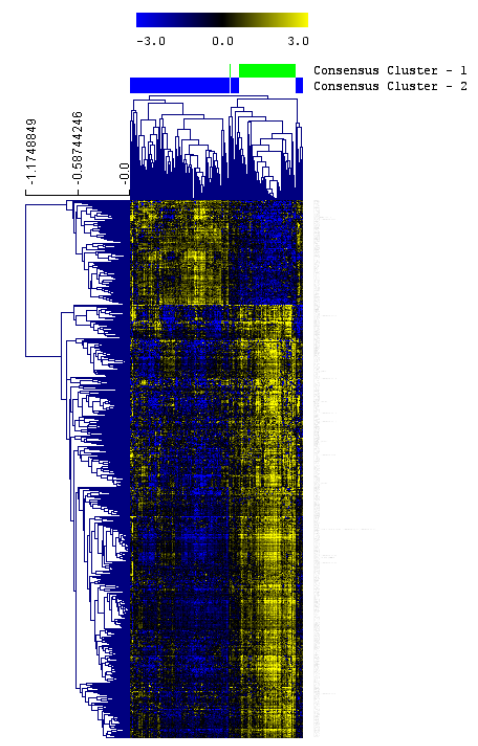
Figure 1. Proteins differentially expressed between the two ccRCC proteomics subtypes identified by a significance analysis of microarrays. HCL dendrogram was built using average linkage. Blue = underexpressed. Yellow = overexpressed.